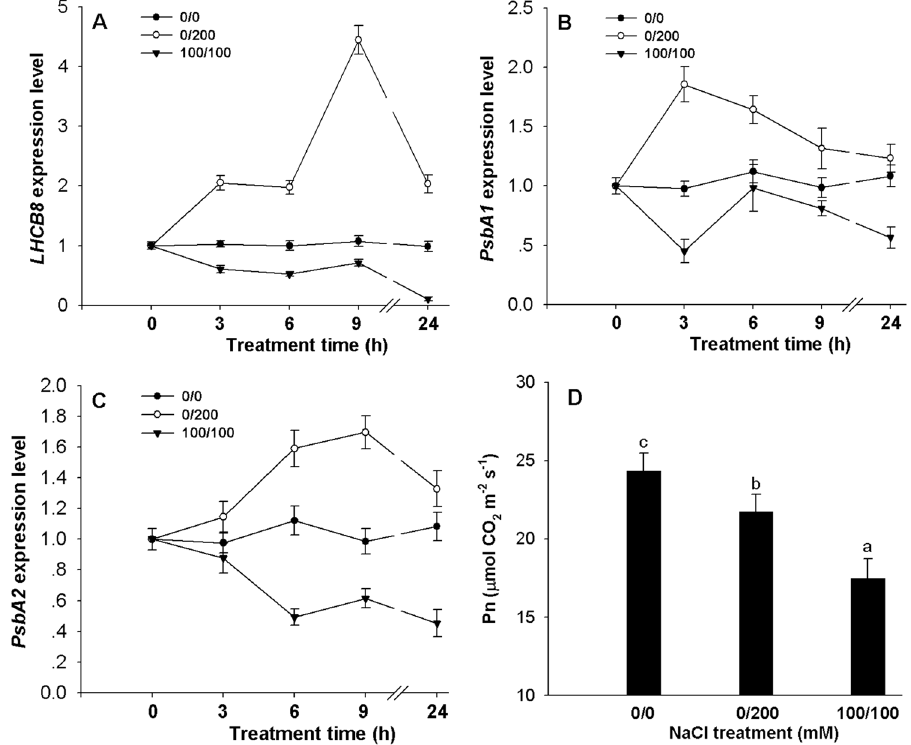
Figure 2. The expression patterns of Lhcb8 ( A ), PsbA1 ( B ) and PsbA2 ( C ) in main-stem leaves under uniform (100/100 mM NaCl) and non-uniform (0/200 mM NaCl) salinity treatments and net photosynthetic (Pn) in leaves at 1 day after salinity treatments. Data are means of six biological replicates ( ± SD). Different letters indicate a significant difference ( P < 0.05) within each